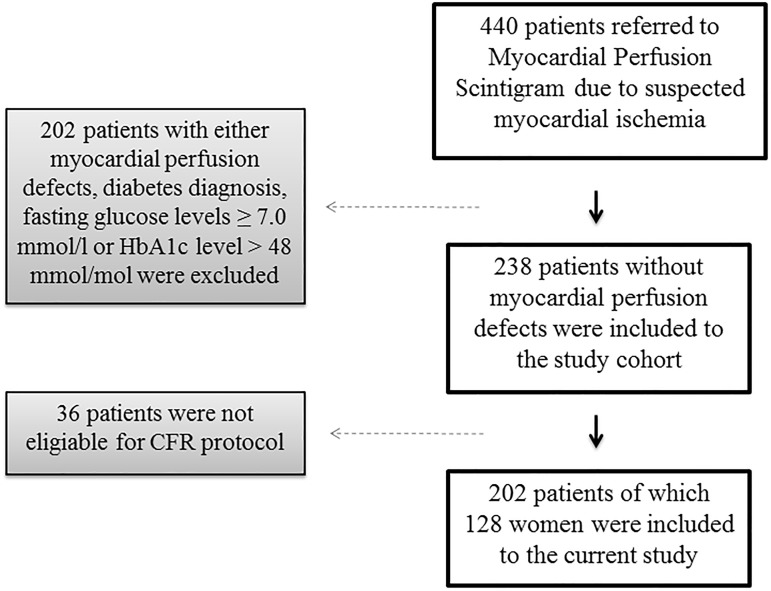
Patient recruitment flowchart over the study population.Flow chart for overview of patient recruitment in the current study. The study was performed at Sahlgrenska University Hospital, Gothenburg Sweden, during the years 2006–2008. CFR = coronary flow reserve.